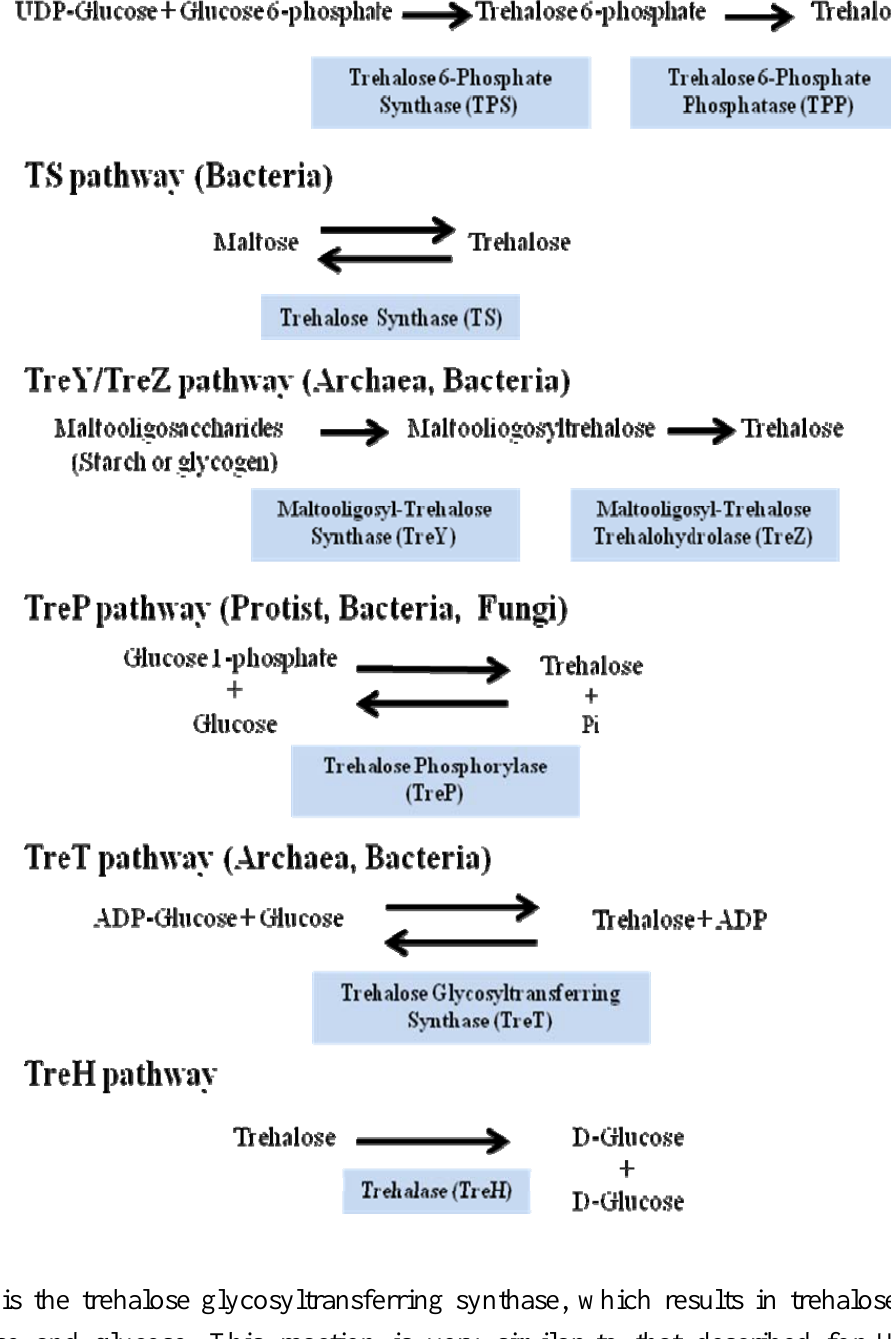
Figure 2. Trehalose biosynthetic and catabolic pathways and distribution in eukaryotes and